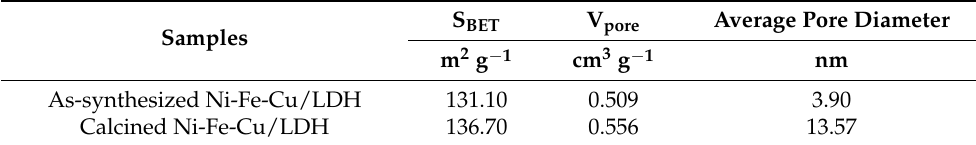
Table 6. Textural characteristics of the as-synthesized and calcined samples.